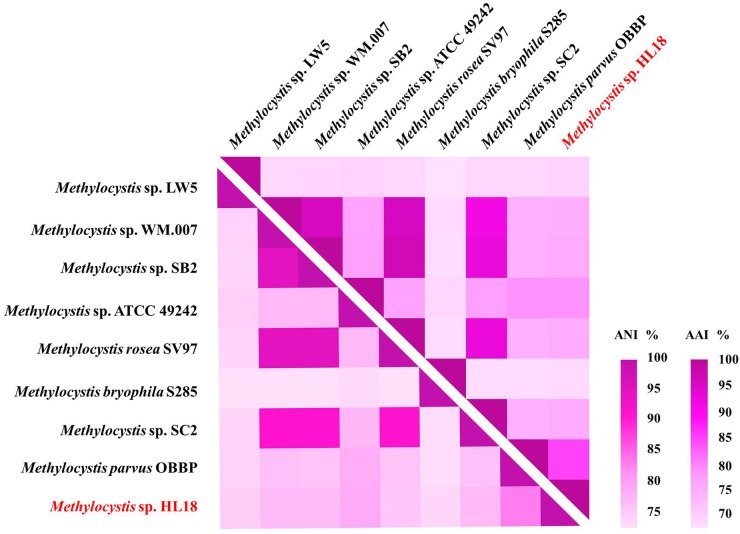
Heatmap of genome relatedness between HL18 and other methanotrophs belonging to Methylocystis, generated by HemI (Deng et al., 2014). The average nucleotide identity (ANI; lower triangle) and average amino acid identity (AAI; upper triangle) between pairs of genomes were calculated using JSpeciesWS (Richter et al., 2016) and CompareM package (https://github.com/dparks1134/CompareM), respectively.